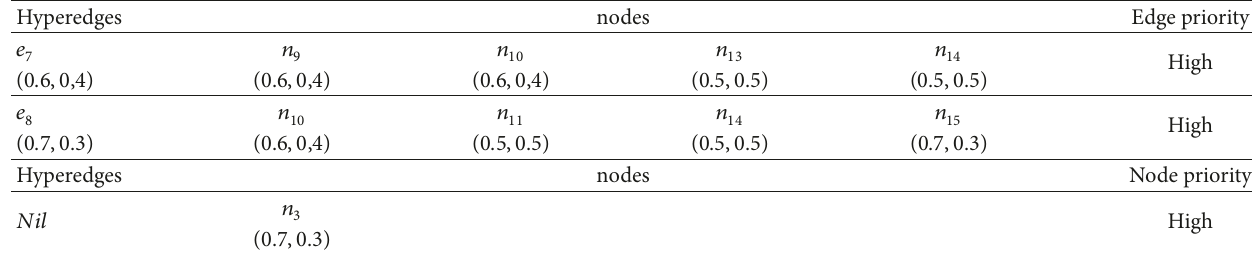
Table 3: Details of hypergraph 𝑌 𝐼𝐹